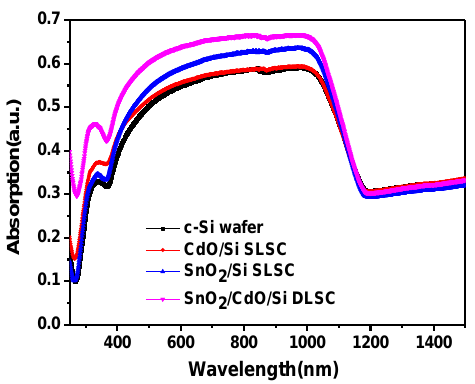
Figure 3. UV–vis–IR absorption spectra for Si wafer, CdO/Si, SnO 2 /Si SLSCs, and SnO 2 /CdO/Si DLSC.